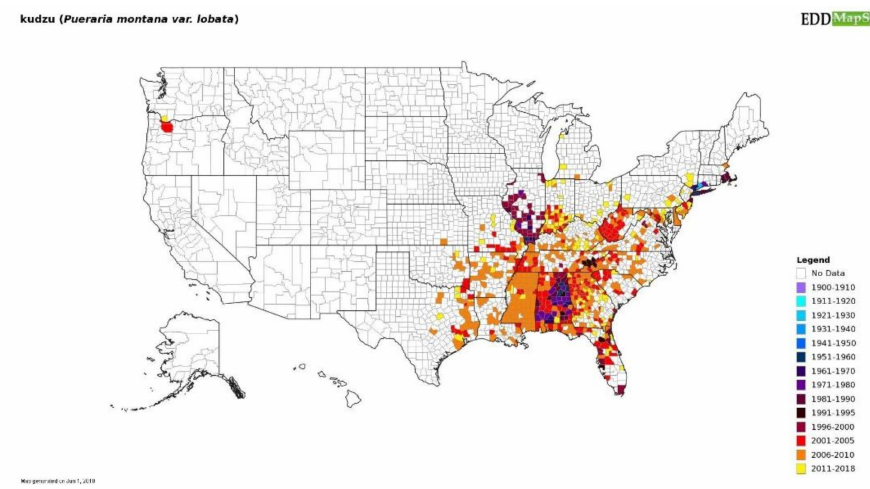
Figure 3. Aggregate reports of the presence of kudzu ( Pueraria montana var. lobata ) over time. The southeast prior to its appearance in Connecticut. This visualization suffers from inadequate early data from the southeastern U.S., to fully tell the story of kudzu’s spread. In contrast, a visualization of the spread of kudzu bug began shortly after its introduction.